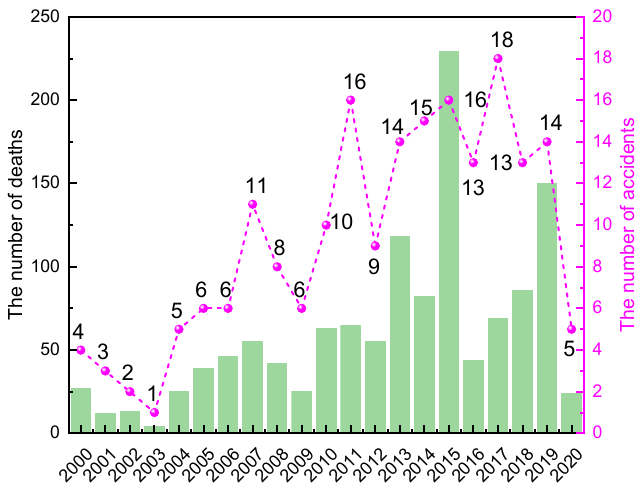
Figure 4. The number of HCA and deaths in different years from 2000 to 2020.